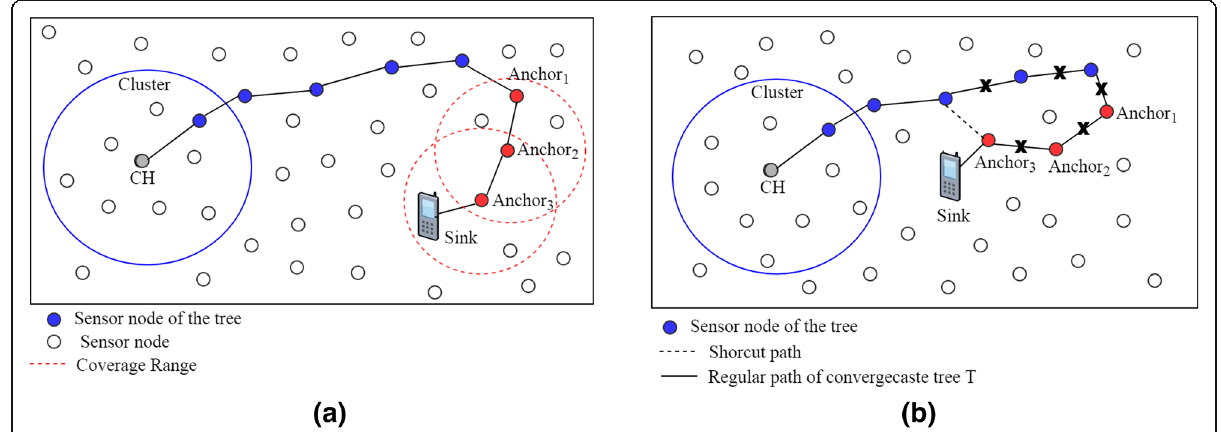
Fig. 3 Example showing a the new anchor selection and b the shortcut